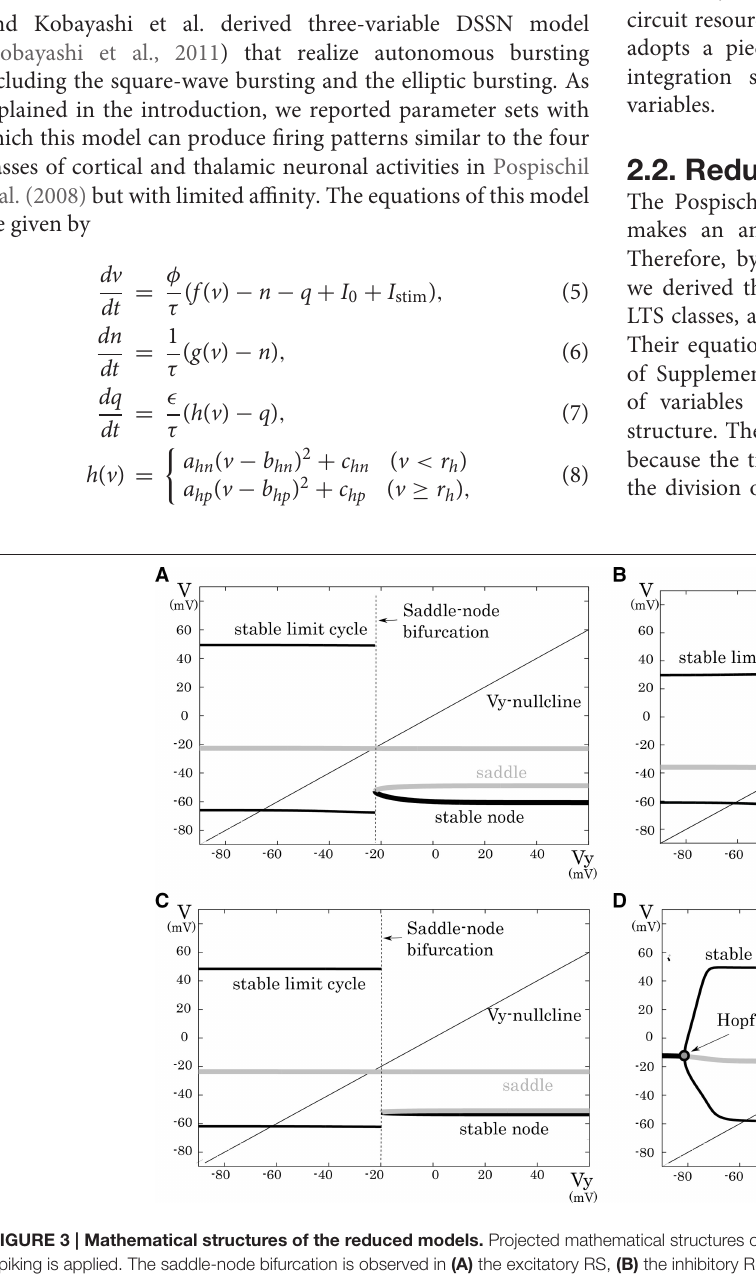
Frontiers in Neuroscience |